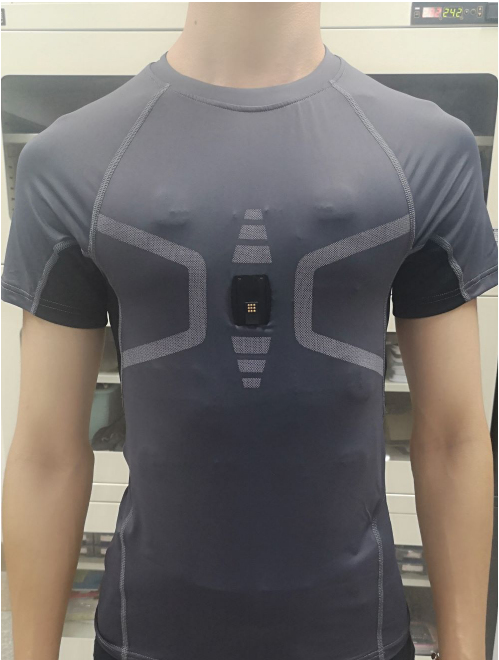
Figure 1. A wearable ECG device that collects the ECG signals through three embedded fabric electrodes in the